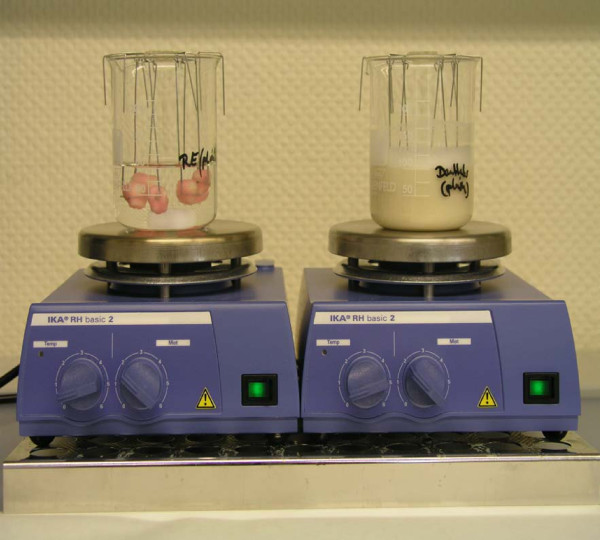
Setup of the incubation procedure. The wax coated teeth were fixed to metal wires and were hanging in the different incubation media. The incubation media were constantly slowly agitated with a magnetic stirrer.